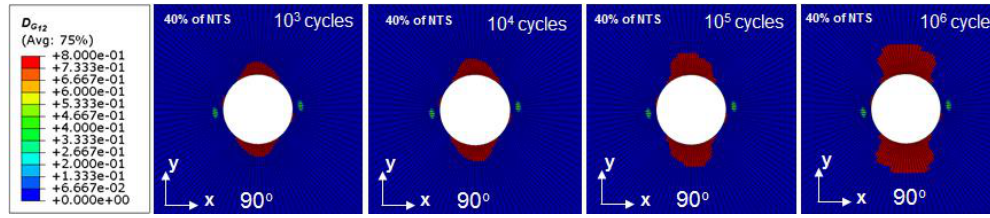
Figure 19. Reduction in strength Y T in 90° plies of the OHT specimen for increasing fatigue cycles.